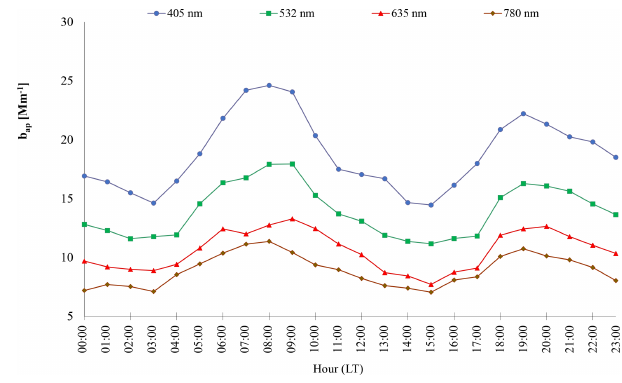
Figure 2. Diurnal profile of the aerosol absorption coefficient (in Mm − 1 ) measured at different